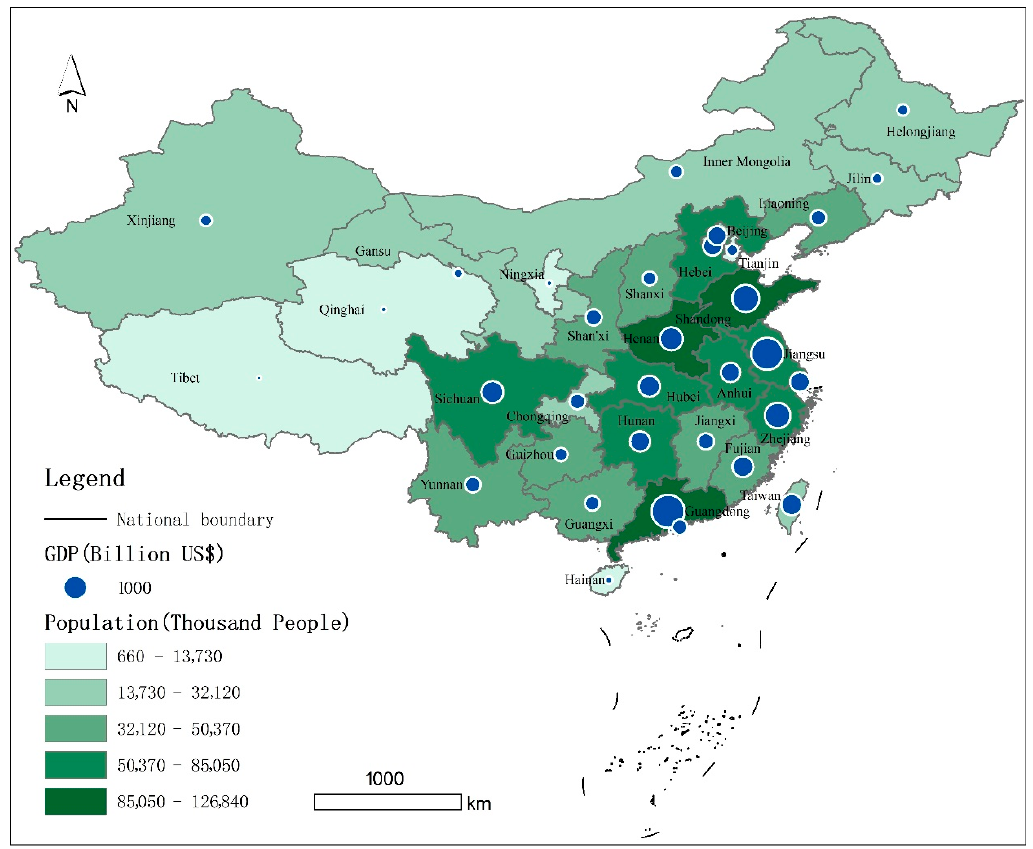
Figure 1. Schematic Diagram of the Study Object.